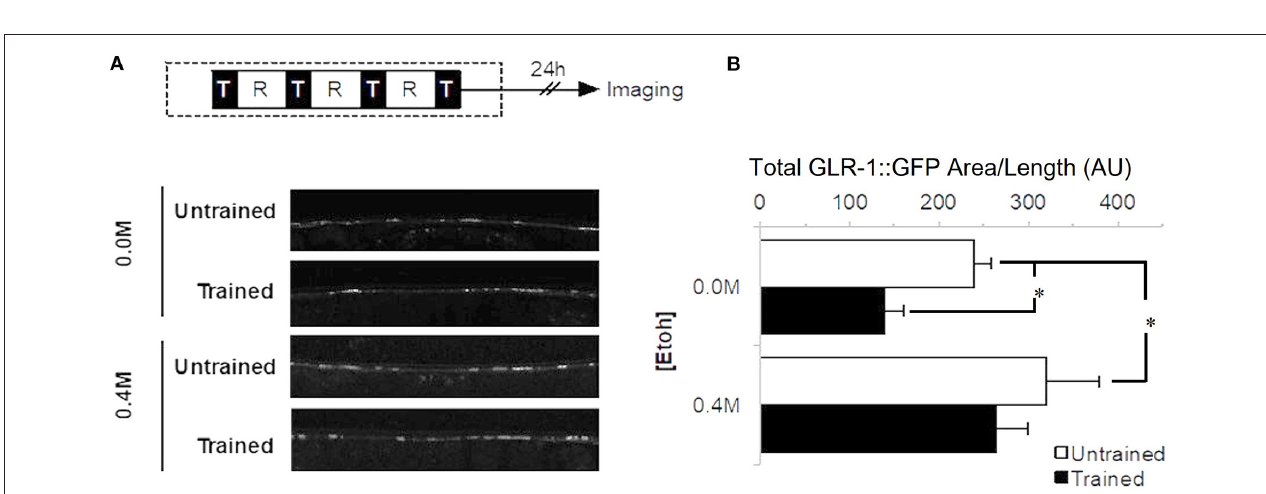
FIGURE 3 | Expression of GLR-1 receptors 24h after long-term memory training. (A) Behavioral protocol whereby long-term memory training is delivered in four blocks (black squares with “T”) separated by 1-h rest periods (white square with “R”). Gray shaded area corresponded to timing of ethanol exposure. Examples of confocal images of GLR-1::GFP expression captured from worms exposed to 0.4M ethanol, comparing punctal expression levels between trained and untrained. (B) GLR-1::GFP punctal expression measured as Mean Total GFP expressing area/worm ( ± SEM) with measures normalized by distance measured along the ventral nerve cord. Measures captured between control ( n = 15) and trained worms (0.0M ethanol; n = 18) as well as control ( n = 17) and trained ( n = 18) worms on 0.4M ethanol with comparisons between trained (black bars) and untrained groups (white bars). * = p <